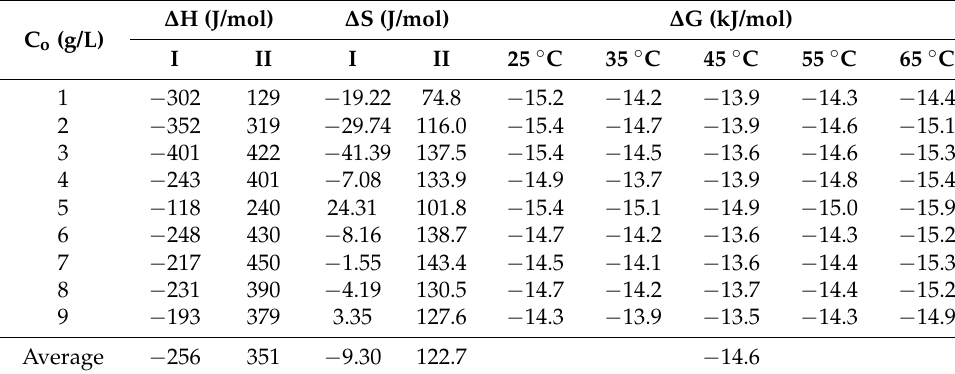
Table 5. Thermodynamic parameters of ectoine adsorption at different temperatures (group I = 25~45 ◦ C; group II = 45~65 ◦